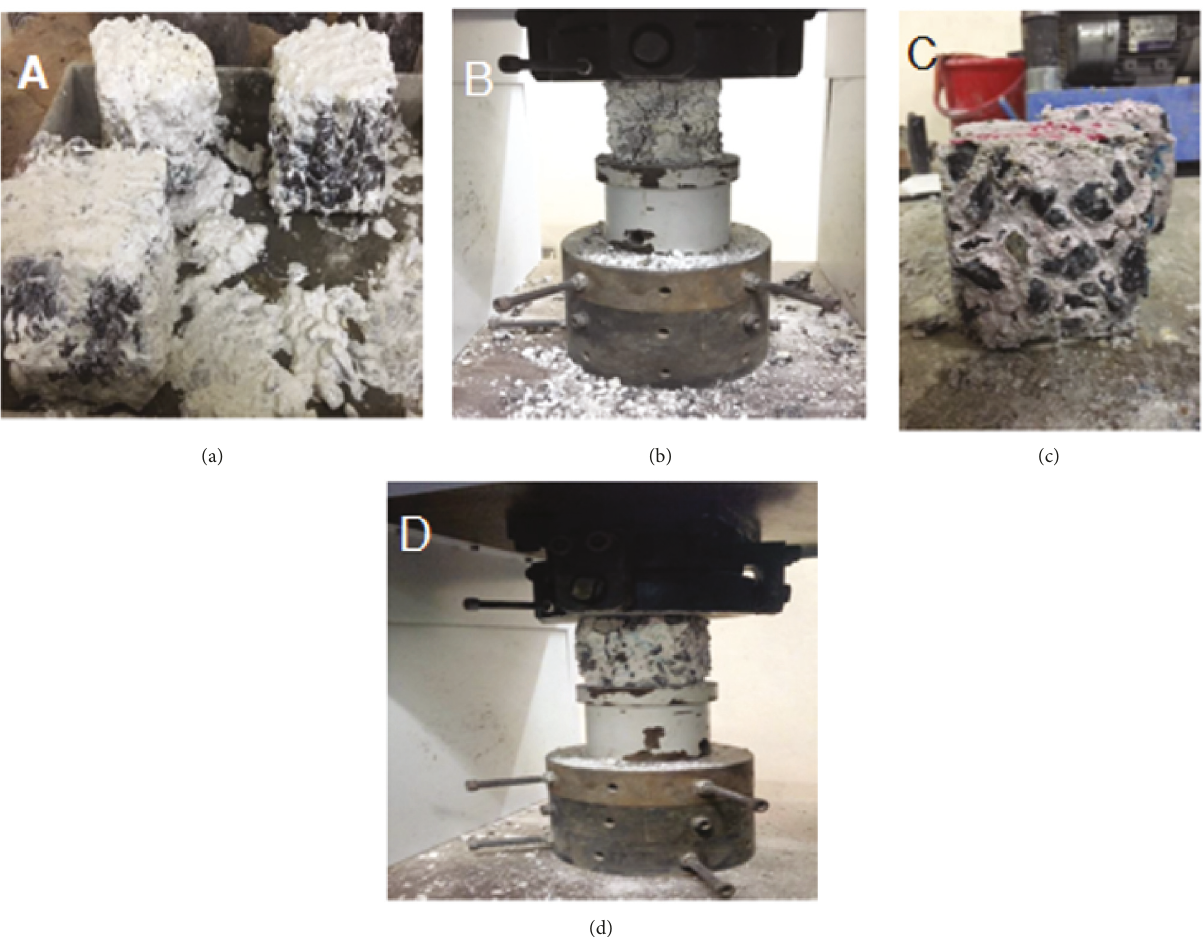
Figure 9: (a) Cubes of the conventional mix (OPC) after removal from acid curing; (b) compressive testing of acid cured conventional cube specimen; (c) cubes of geopolymer mix (GC-3) after removal from acid curing; (d) compressive testing of acid cured geopolymer cube